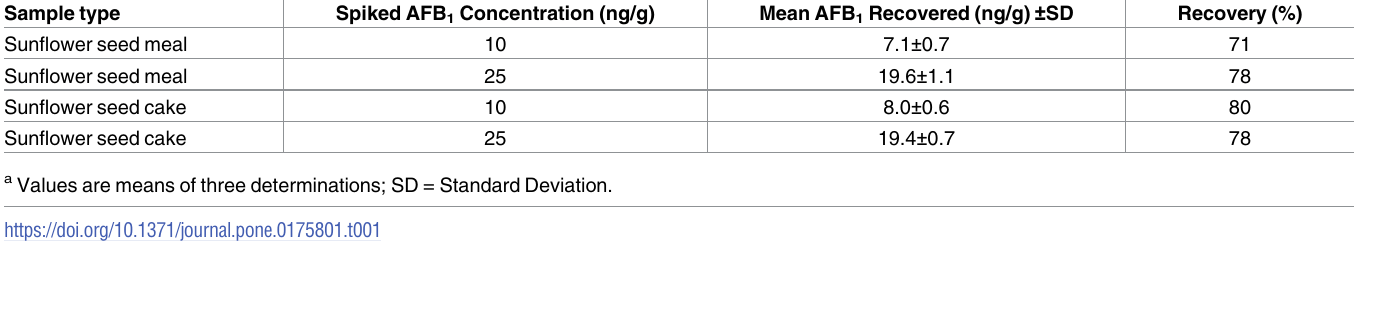
Table 1. Recoveryof AFB 1 spiked in aflatoxin-free sunflower seed and cakes a . Sample